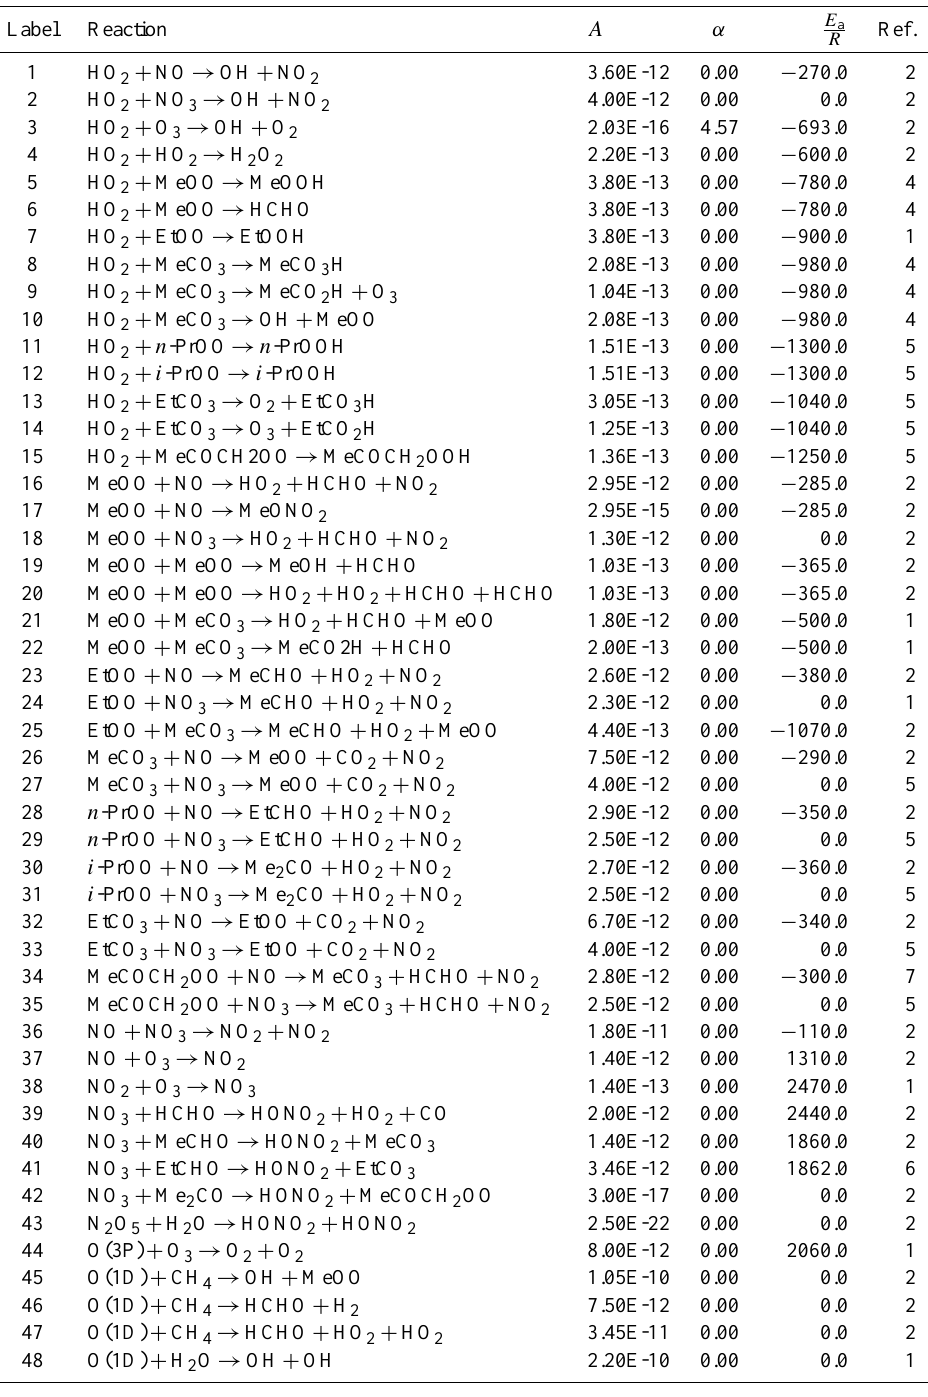
Table 5. Bimolecular reactions in the UKCA standard tropospheric (StdTrop) scheme, where Me = CH 3 , Et = C 2 H 5 , Pr = C 3 H 7 , PAN = peroxy acetyl nitrate, PPAN = peroxy propionyl nitrate, and MGLY = methylglyoxal. The rate coefficient of a bimolecular reaction (cid:16) T (cid:17) (cid:17) α (cid:16) − E a , where A is the pre-exponential factor, T is the temperature, R is the gas constant, α is the exp is given by k = A RT 300